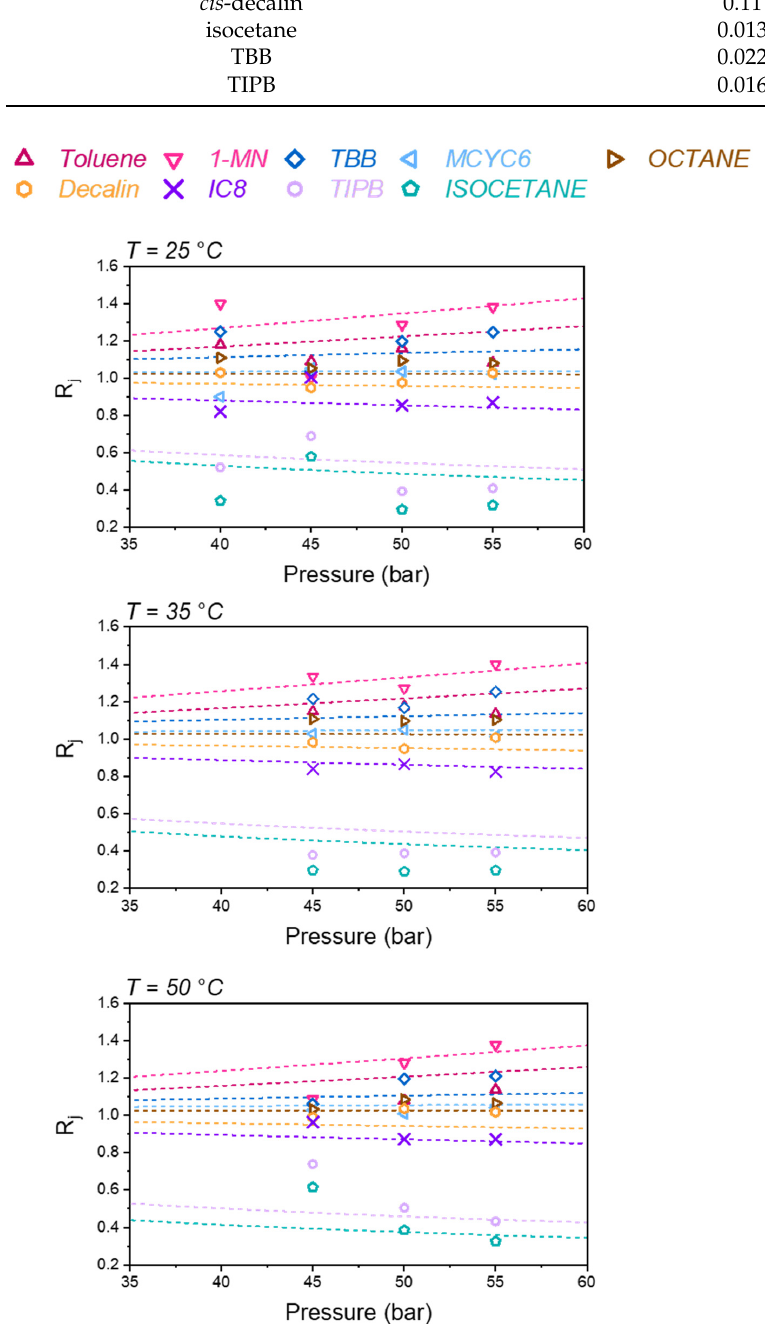
Figure 4. Separation coefficients (Equation (2)) for the SBAD-1 membrane separation of a complex liquid feed composition listed in Table 4. Symbols are experimental data [3] and curves are predictions using Equation (6). In the top panel, the 40 bar experimental data are for T = 22 °C and the remaining data are at 25 °C.